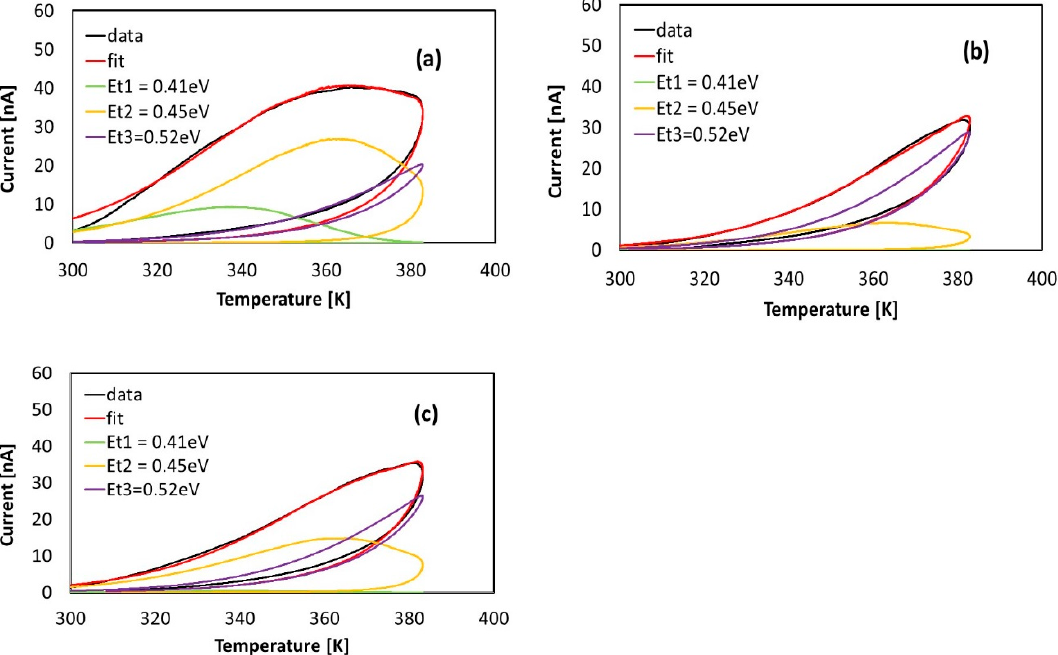
( b ) Figure 6. ( a ) Photoconductivity measured during the priming process on a single crystal CsPbBr 3 sample illuminated with a 400 nm LED at T i = 290 K, V b = 2 V; ( b ) TSC cycle (heating and cooling) measurement carried out after priming, showing the absence of thermally stimulated peaks.